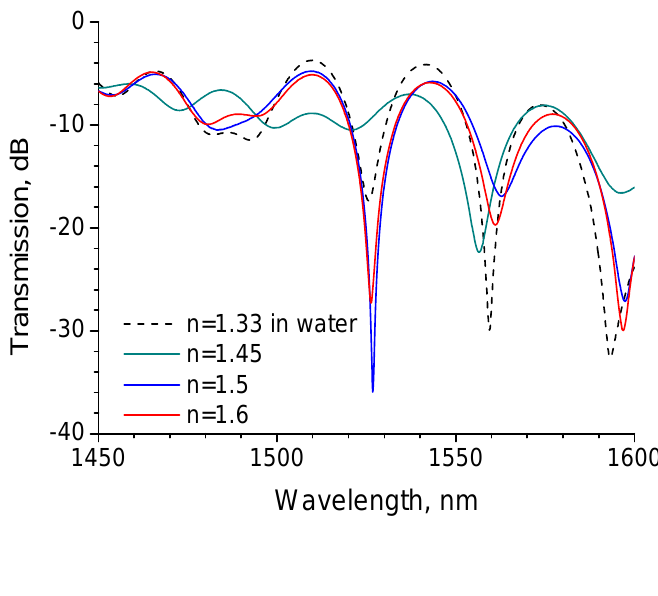
Figure 5. Transmission spectra of a 20-mm-long straight LPG surrounded by a medium having a refractive index that is higher than that of